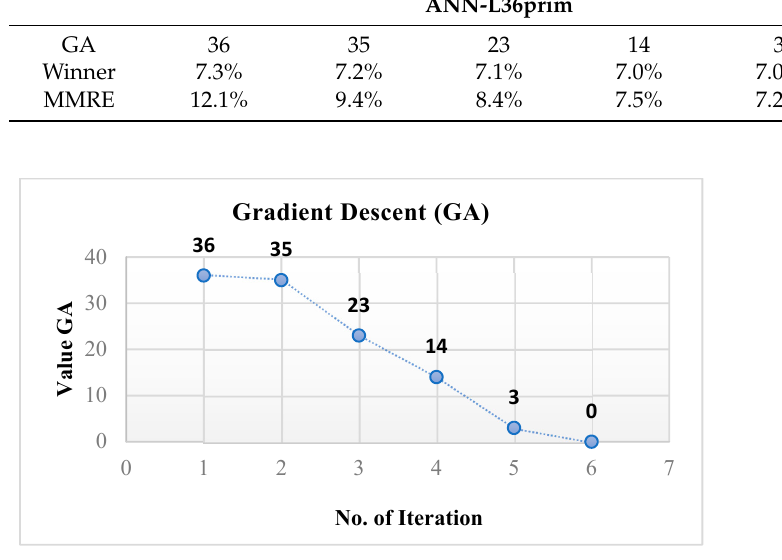
Figure 7. GA for ANN-L36prim-training part (UCP).